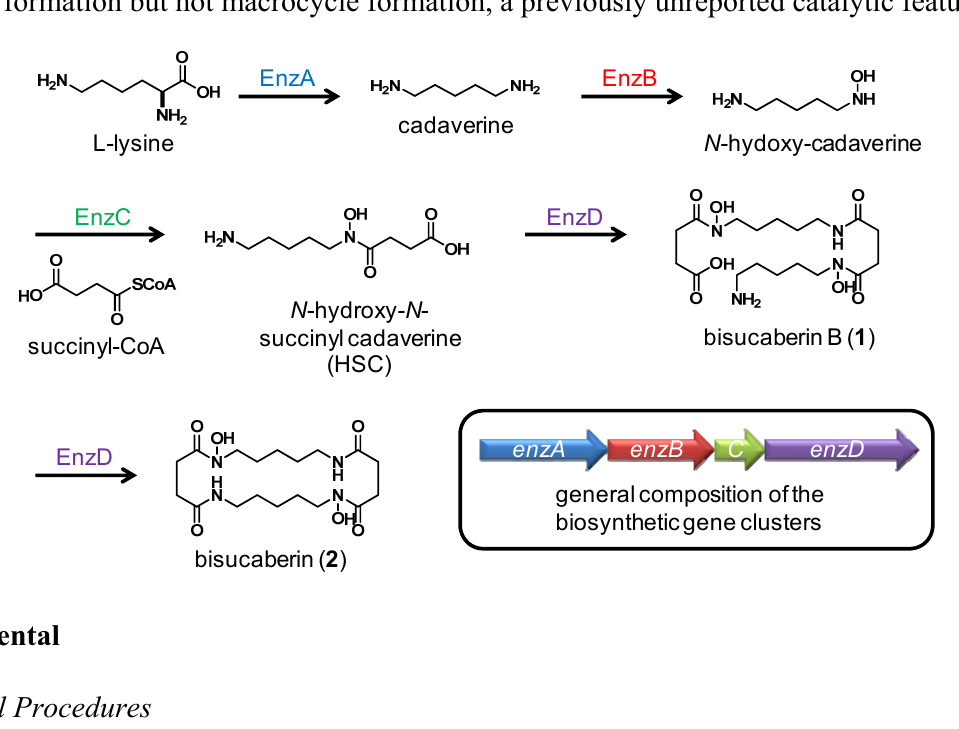
biosynthetic gene clusters. The fourth enzyme in the T. mesophilum is believed to catalyze dimer formation but not macrocycle formation, a previously unreported catalytic